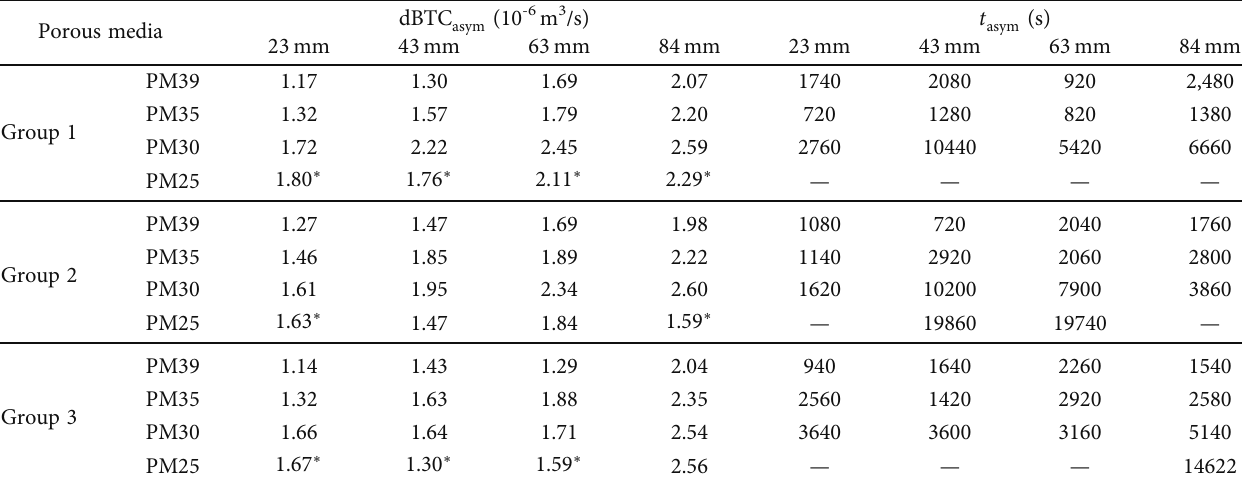
Table 2: Asymptotic values of the dilution breakthrough curve ( dBTC cross-sections located 23, 43, 63, and 84 mm away from the tracer source in all the porous media. Porous